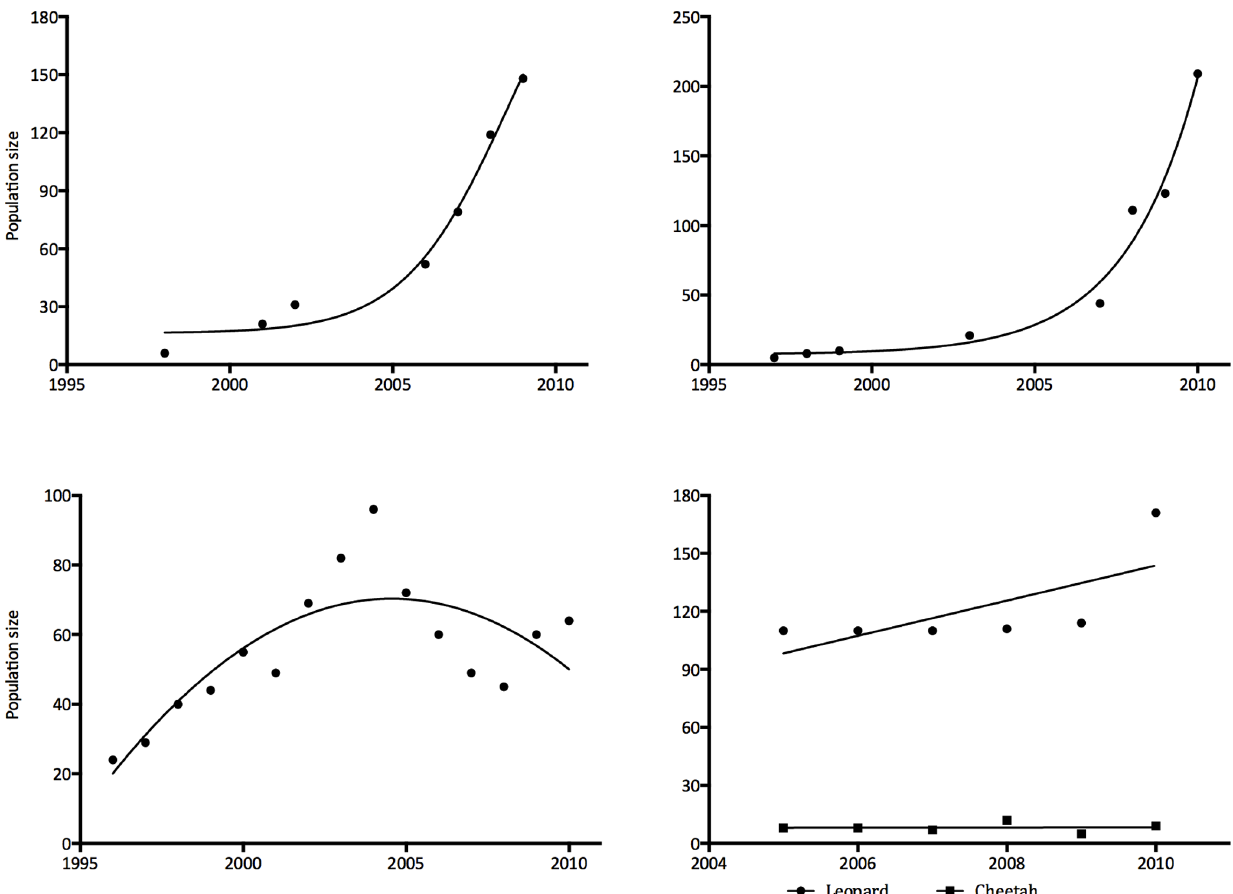
Figure 2. Population trends of a) lions, b) spotted hyenas, c) African wild dogs, and d) leopards (diamonds) and cheetahs (squares) in the Save´ Valley Conservancy from 2000 to 2010.